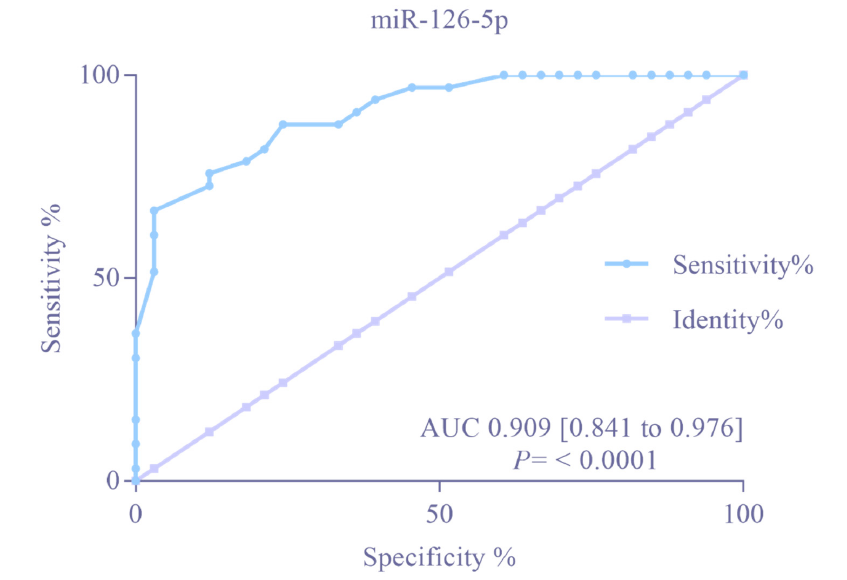
Figure 2. Receiver operating characteristic curves of miR-126-3p and miR-126-5p in Turner Syndrome patients compared to healthy volunteers, as determined by single RT-qPCR.